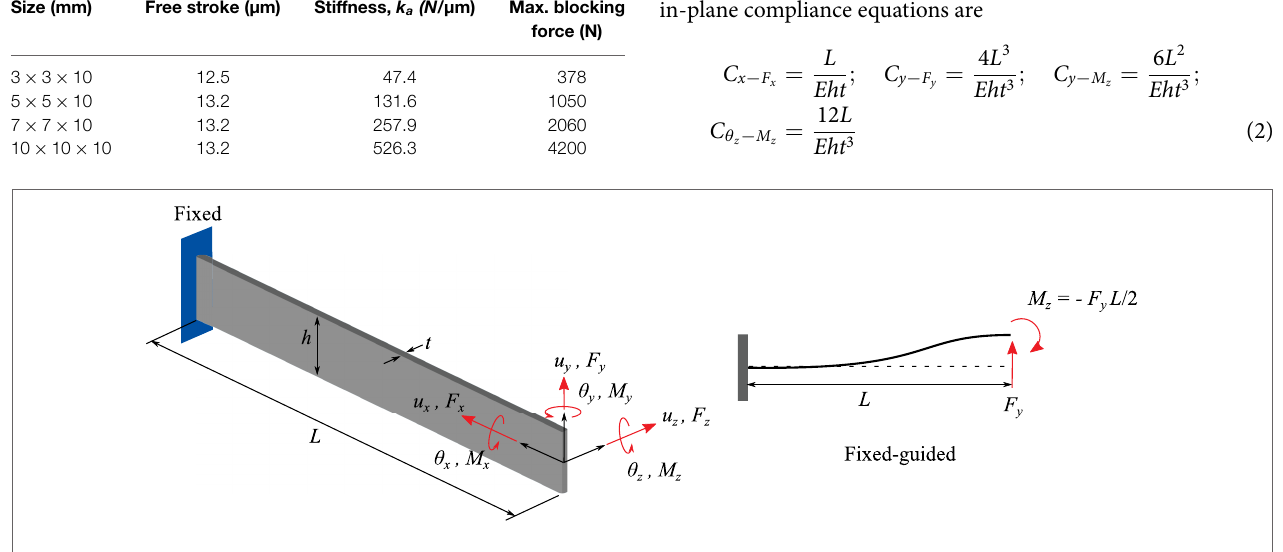
FIGURE 5 | (Left) A flexure model with the applied loads and displacements at its free end. (Right) A flexure model with fixed-guided boundary condition.